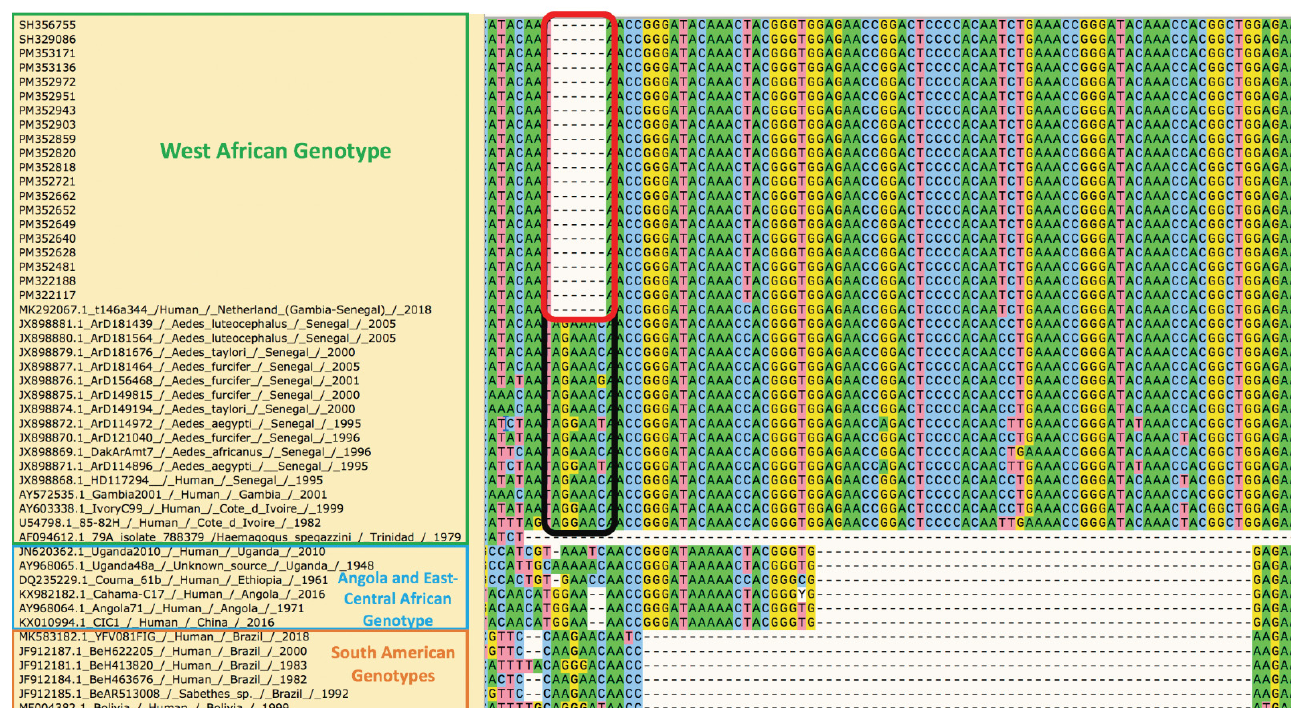
Figure 2. Alignment of portion of the variable domain within the 3 ′ UTR downstream the yellow fever virus polyprotein. (Black band surrounds the first 6 nucleotides downstream the ORF 3 ′ terminus; red band surrounds the deletion area of newly sequenced strains).